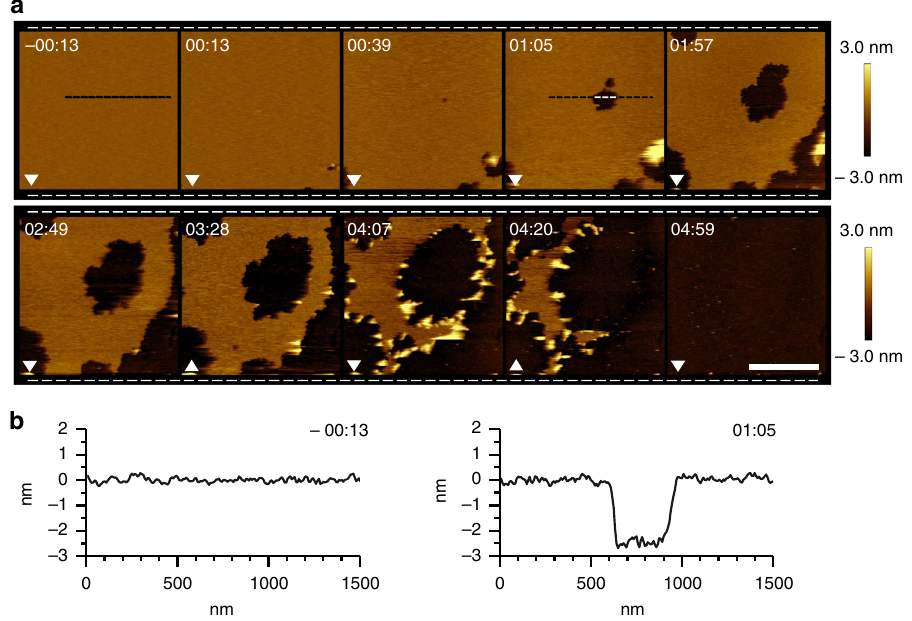
Fig. 5 C 3 -capsids porating phospholipid bilayers. a In-water AFM imaging of supported lipid bilayers treated with C 3 -capsids (3 µ M total peptide). Topography (height) images, captured at 13 s per frame, are shown. The time stamp corresponds to the middle line of each AFM scan, referenced to the time (00:00) of capsid injection. White arrowheads indicate the AFM scan direction. The scale bar is 1 μ m. b Cross-sections along the lines marked in ( a , − 00:13 and 01:57) before (left) and after (right) the addition of